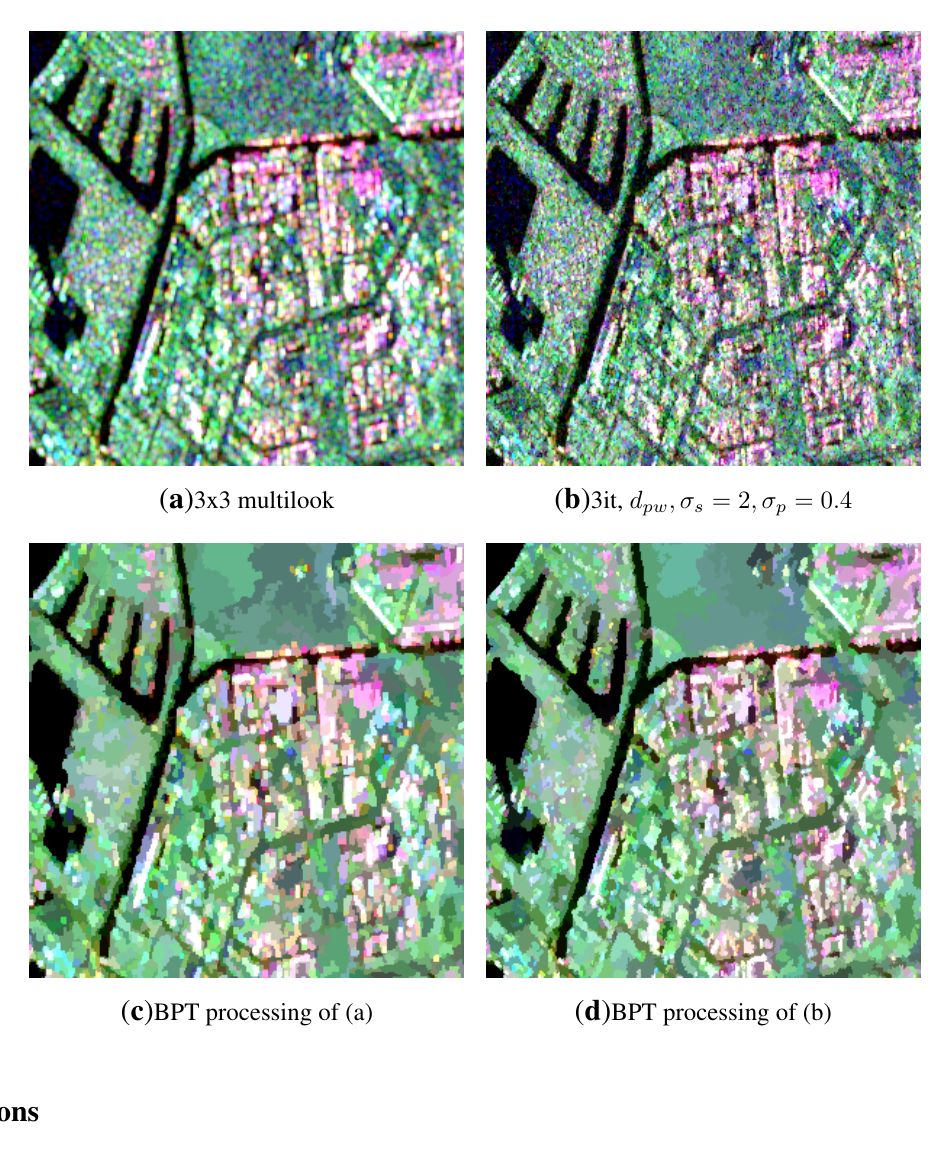
Figure 10. Pauli RGB ( | HH − V V | , | HV + V H | , | HH + V V | are assigned to RGB channels, respectively) of the 3 × 3 multilook ( a ) and the proposed method with 5 × 5 local window V ( b ) as initial filtering for matrix regularization. The corresponding BPT-based field segmentation results are shown on ( c ) and ( d ),